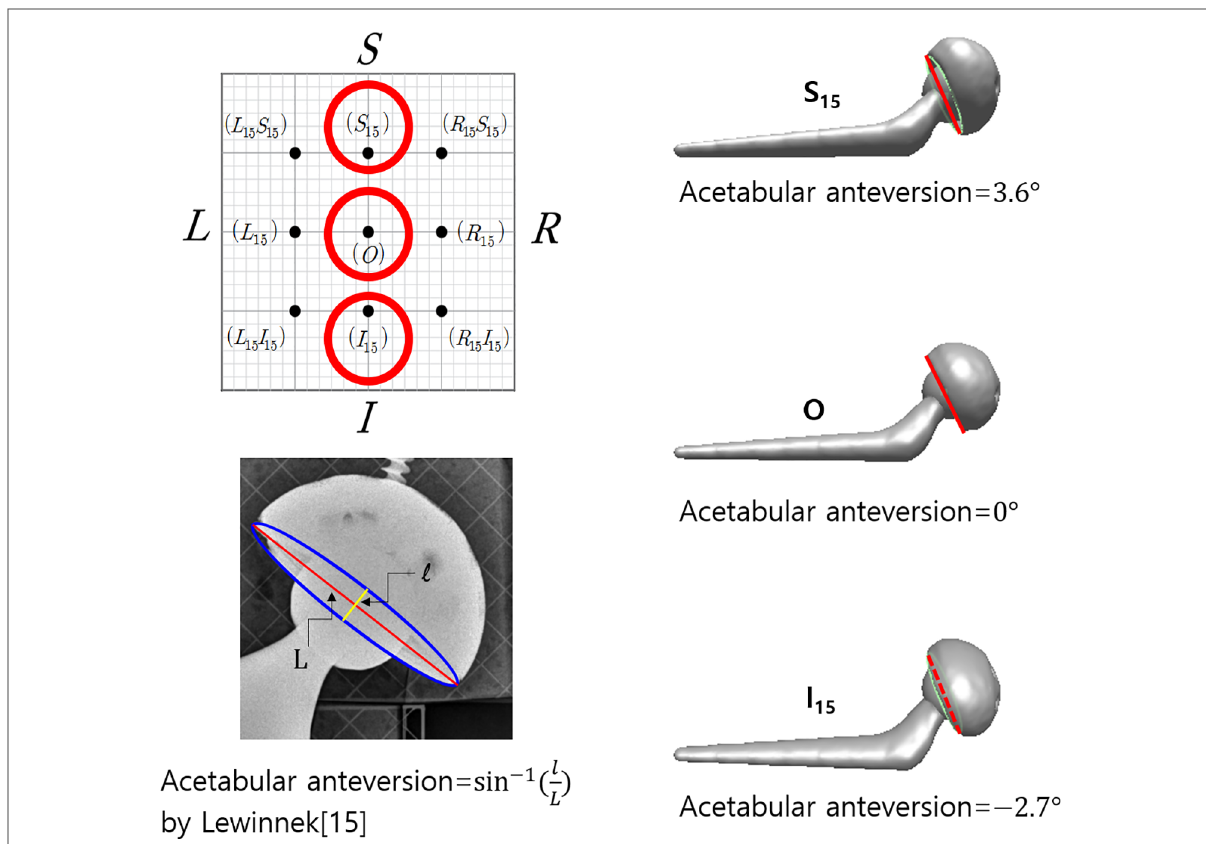
FIGURE 10 Measurement of acetabular anteversion using CAD to investigate the effect of the eccentricity of the prosthesis from the center of the x-ray beam on the acetabular anteversion. The same x-ray images used for polyethylene measurements were also used for the measurement using CAD software, i.e., Rapidform 2006 ® (INUSTechnology, Seoul, Korea). The superior and inferior placements of the prosthesis bring about errors in acetabular anteversion by the nature of perspective x-ray